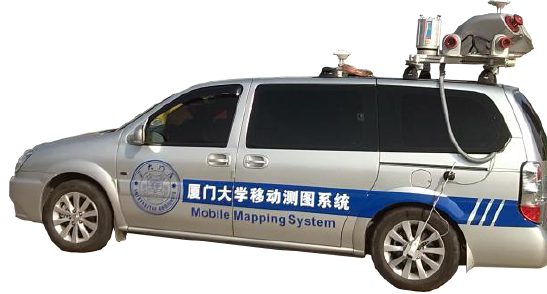
Figure 4. RIEGL VMX-450 mobile LiDAR